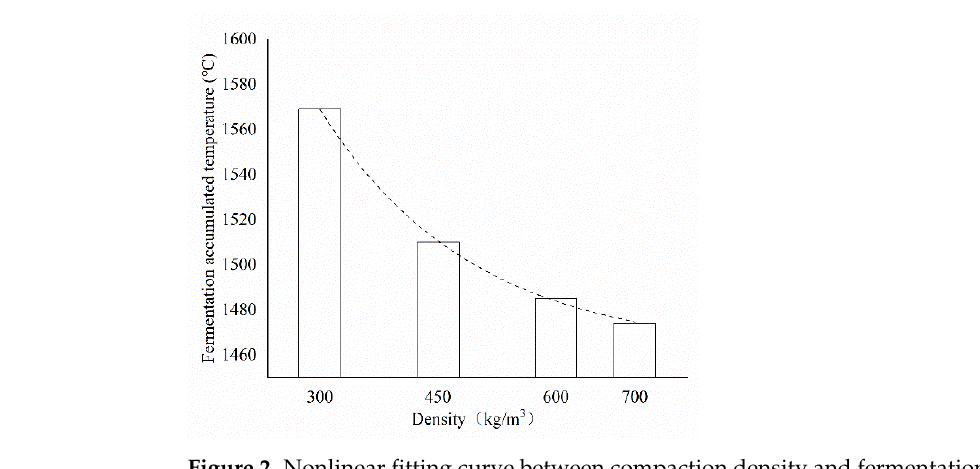
Figure 2. Nonlinear fitting curve between compaction density and fermentation accumulated tem- perature of whole-plant corn silage.